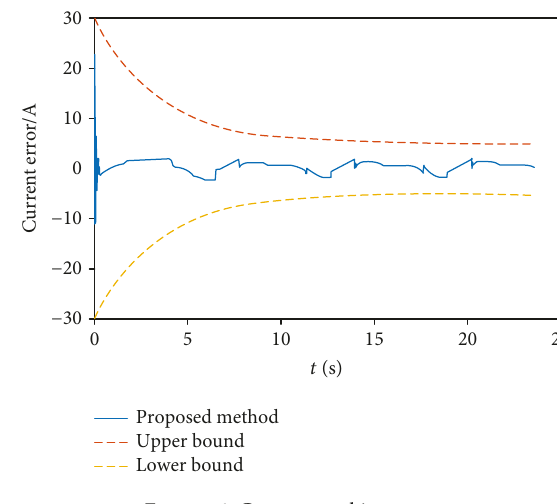
Figure 6: Current tracking error.